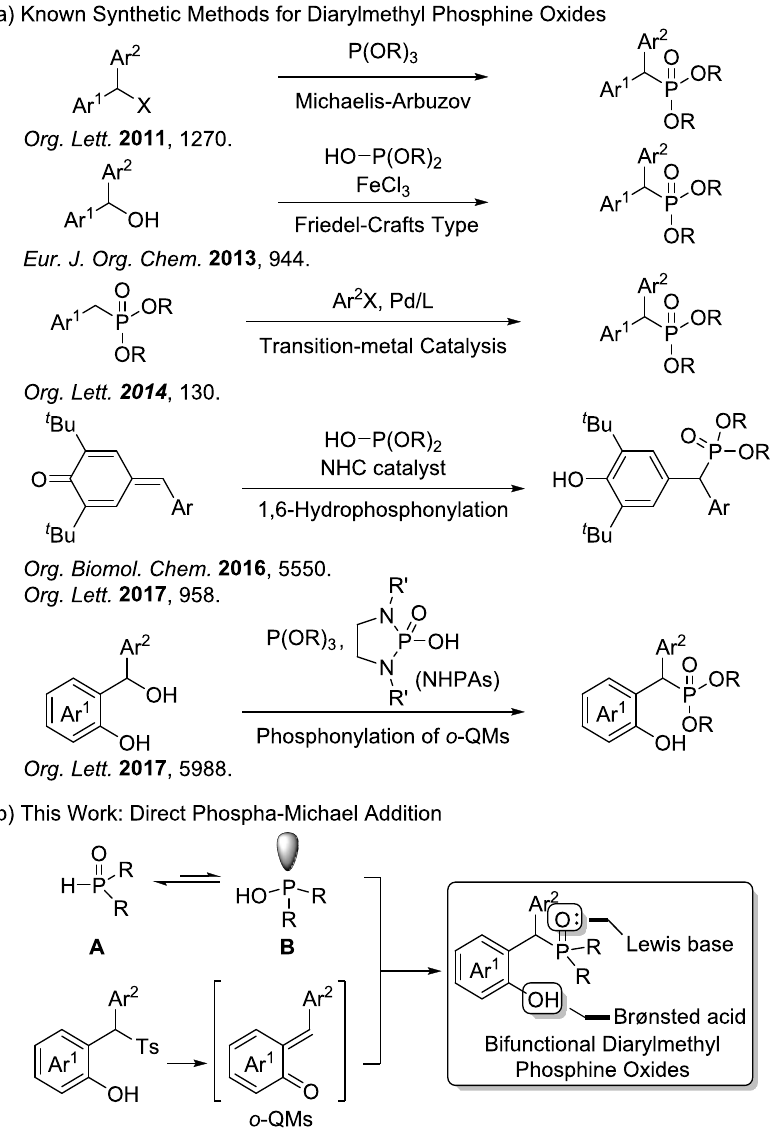
Scheme 1. Synthesis of diarylmethyl phosphine